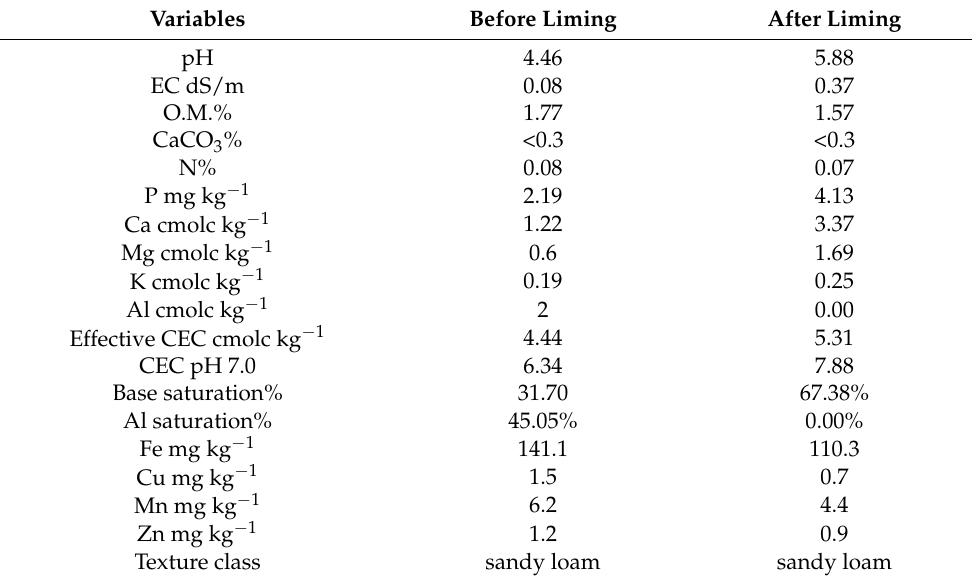
Table 2. Attributes of the soil used for the experiment with cacao genotypes in a greenhouse before and after